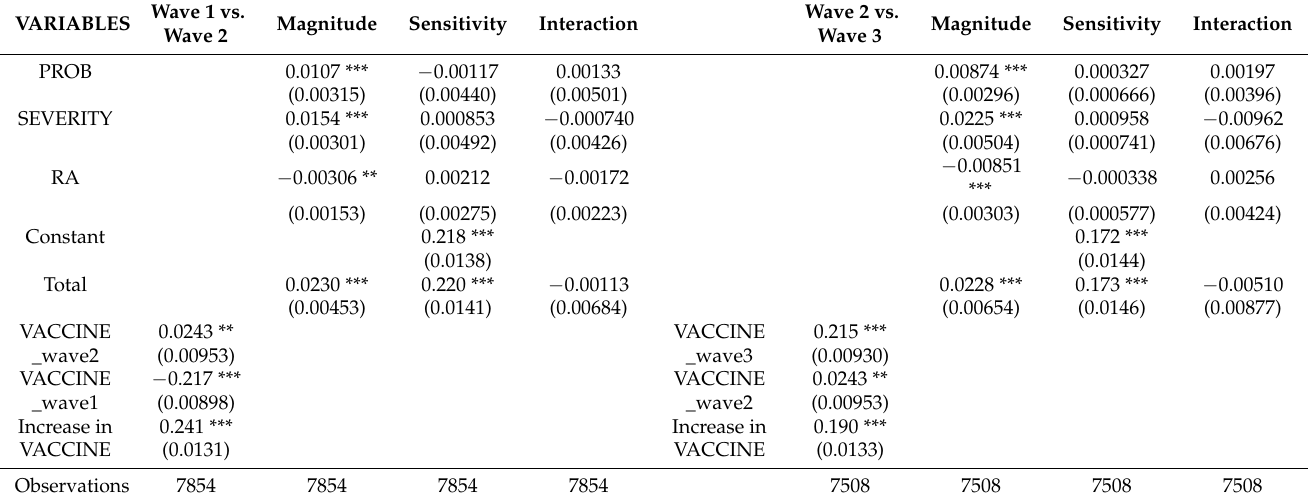
Table 7. Results of Oaxaca